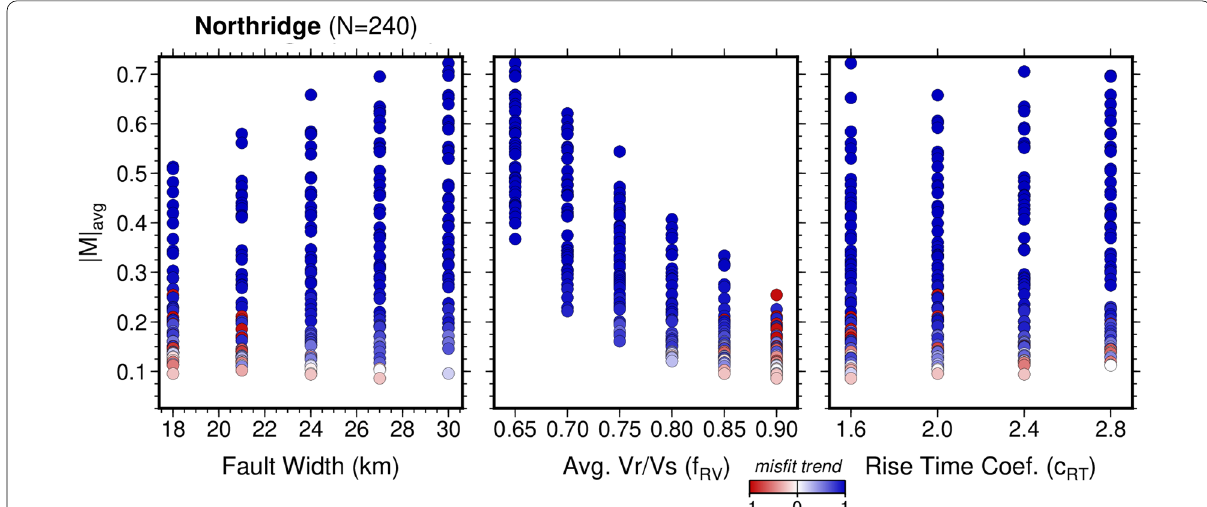
Fig. 5 Average absolute misfit (| M | avg ) for the 240 Northridge earthquake simulations as a function of fault width (left panel), f RV (middle panel), and c RT (right panel). The color scale labeled misfit trend indicates if a realization over-predicts (red shading) or under-predicts (blue shading) the observed motions, on average